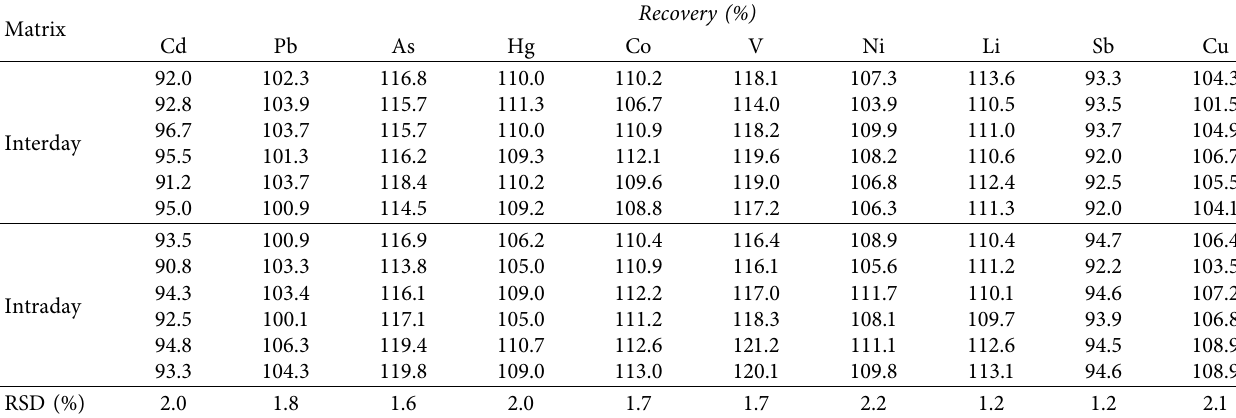
Table 3: Precision of 10 elements in parecoxib